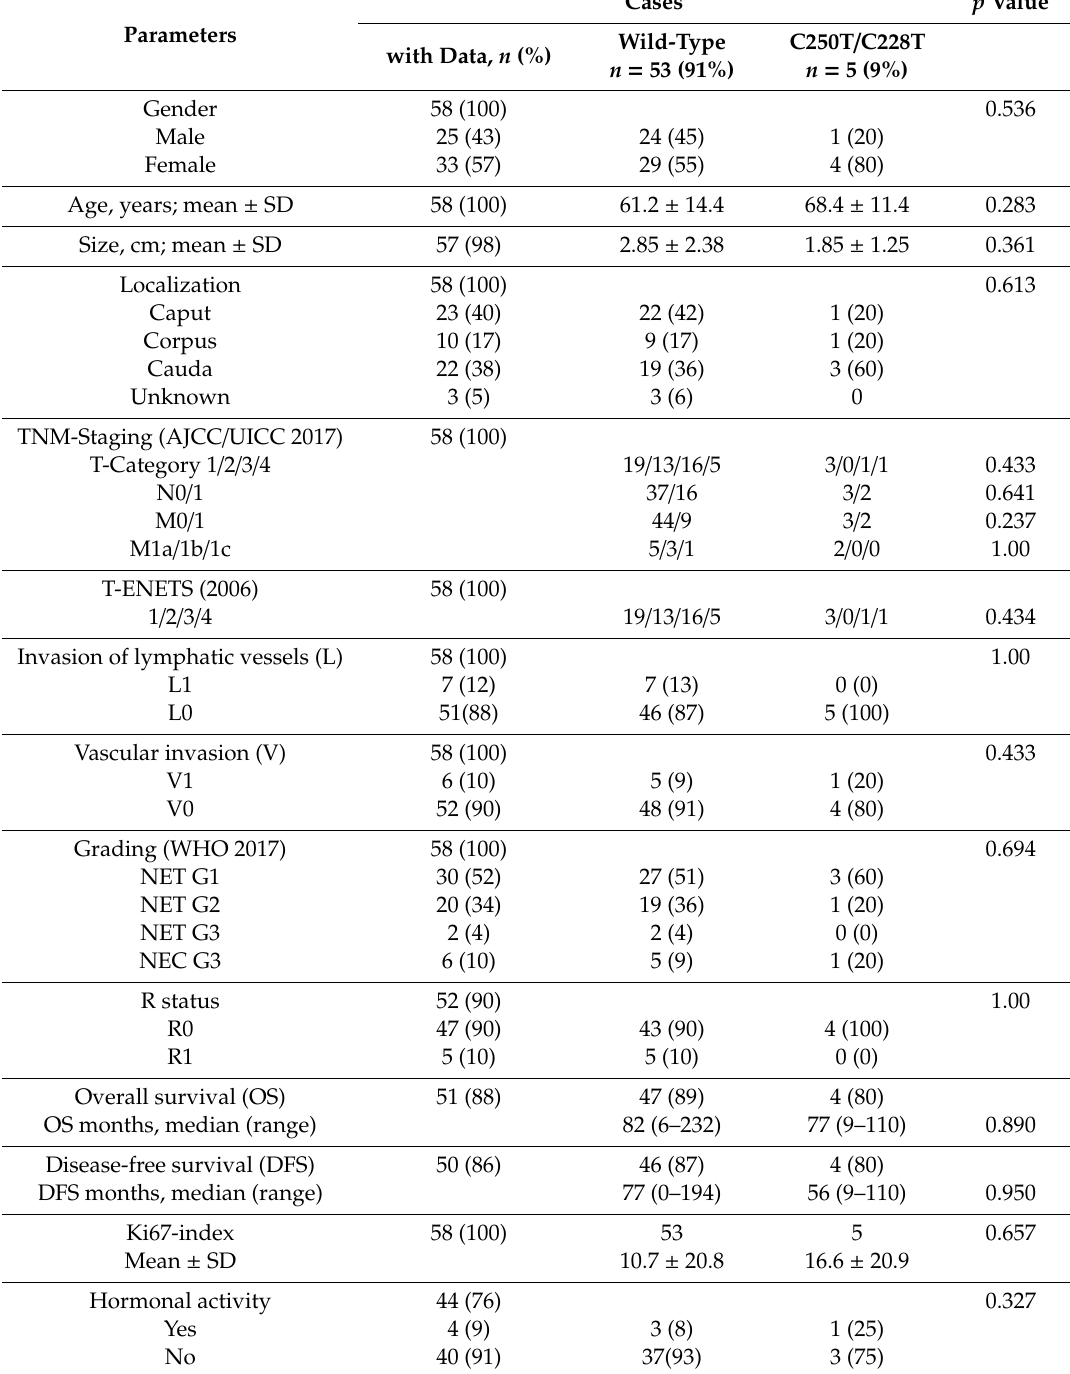
Table 1. Clinicopathological features of sporadic pNEN patients grouped according to TPM status *.